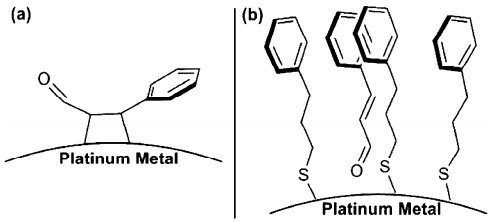
Figure 12. Adsorption model for Cinnamaldehyde on the catalyst surface: ( a ) flat adsorption mode through the C=C double bond onto uncoated Pt surface; ( b ) upright molecular orientation in the presence of 3 ‐ Phenyl ‐ 1 ‐ propanethiol SAMs. Reproduced with permission from ref. [87]. Copyright 2014, American Chemical Society.